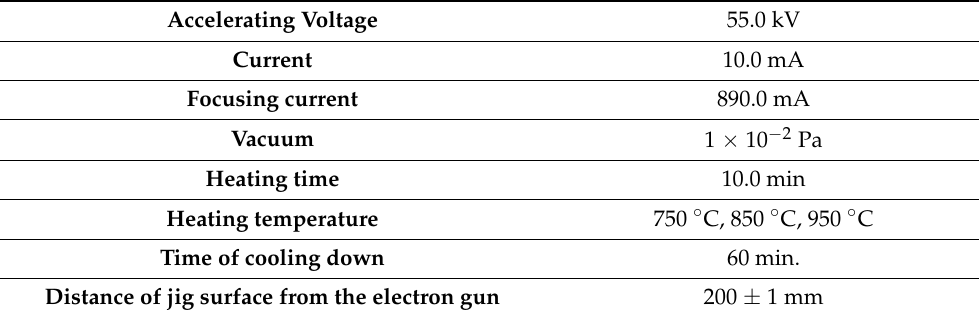
Figure 3. Settingthejigwithspecimensontheworkingtableandrealrepresentationofthesoldering process. Table 2. Soldering